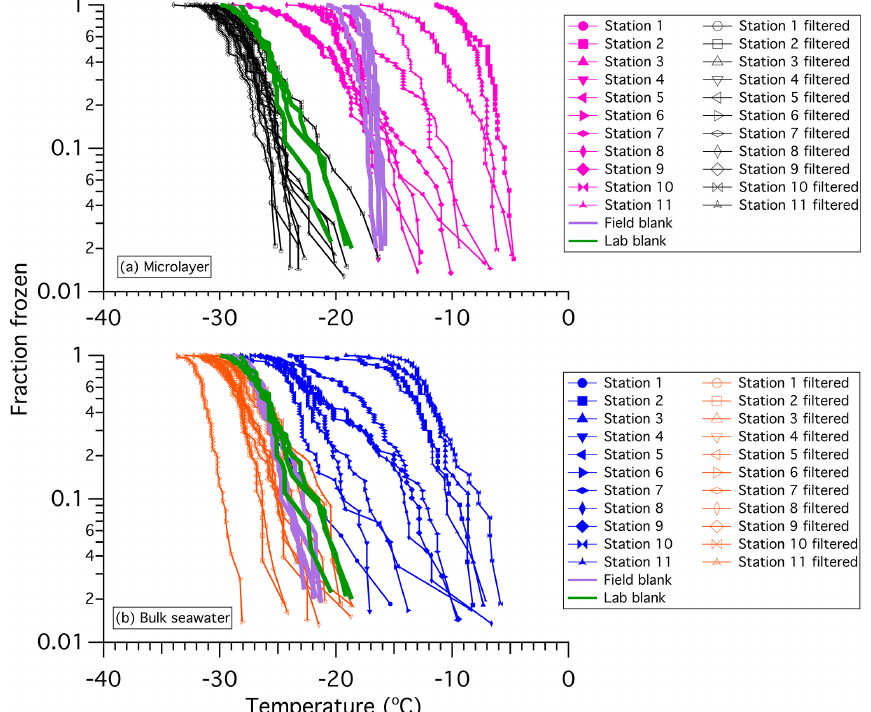
Figure 2. Fraction of droplets frozen (in the immersion mode) versus temperature for (a) the microlayer and (b) bulk seawater. Each line shows the results for three replicate experiments of a sample or a sample passed through a 0.02µm filter, with a total of between 45 and 60 freezing events in each set. Each data point corresponds to a single freezing event in the experiments. Also included are the laboratory blanks (ultrapure water passed through a 0.22µm filter) and the field blanks (ultrapure water sampled through the sampling catamaran). All microlayer and bulk seawater freezing points were corrected for freezing point depression to account for dissolved salts in seawater (Sect. 2.2.3). The uncertainty in temperature is ± 0 . 3 ◦